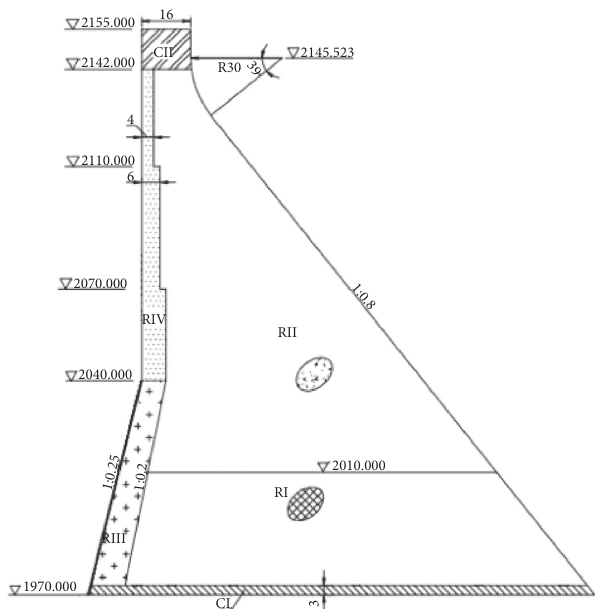
Figure 1: The geometric dam section and concrete partition (unit: m).